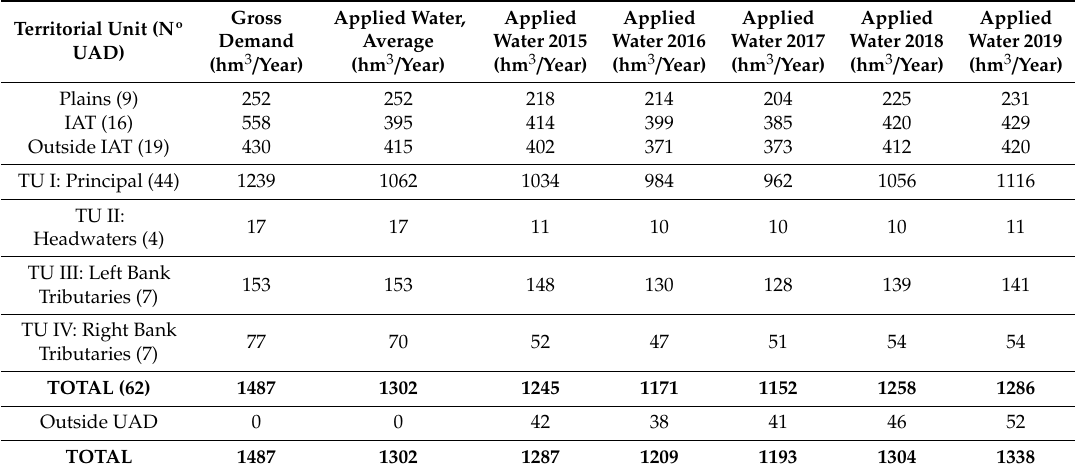
Table 7. Evolution of applied water 2015–2019 Source: HPO. Own